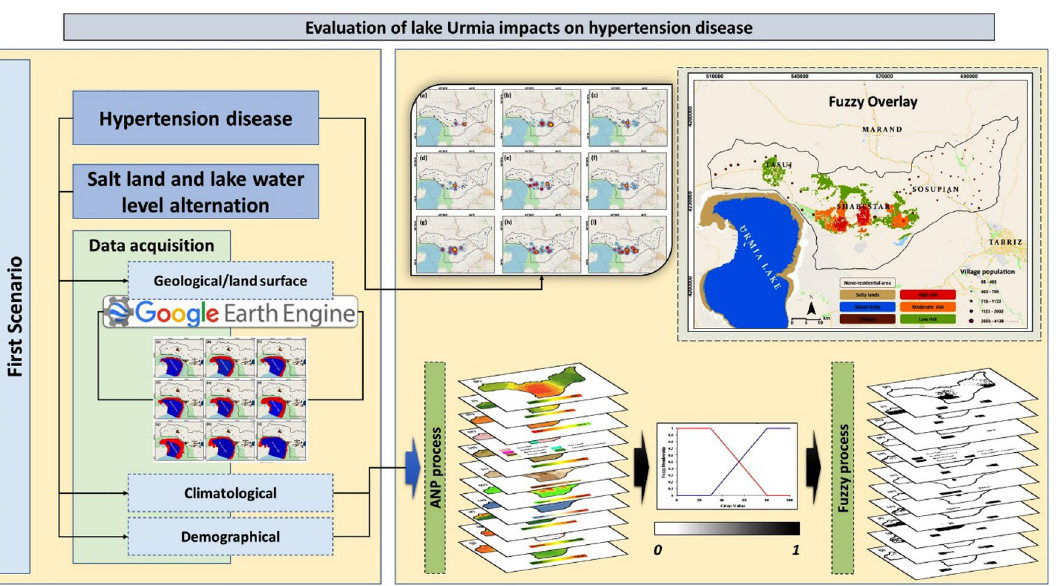
Figure 3. Main steps of the implemented research methodology for human health risk mapping using integrated spatiotemporal